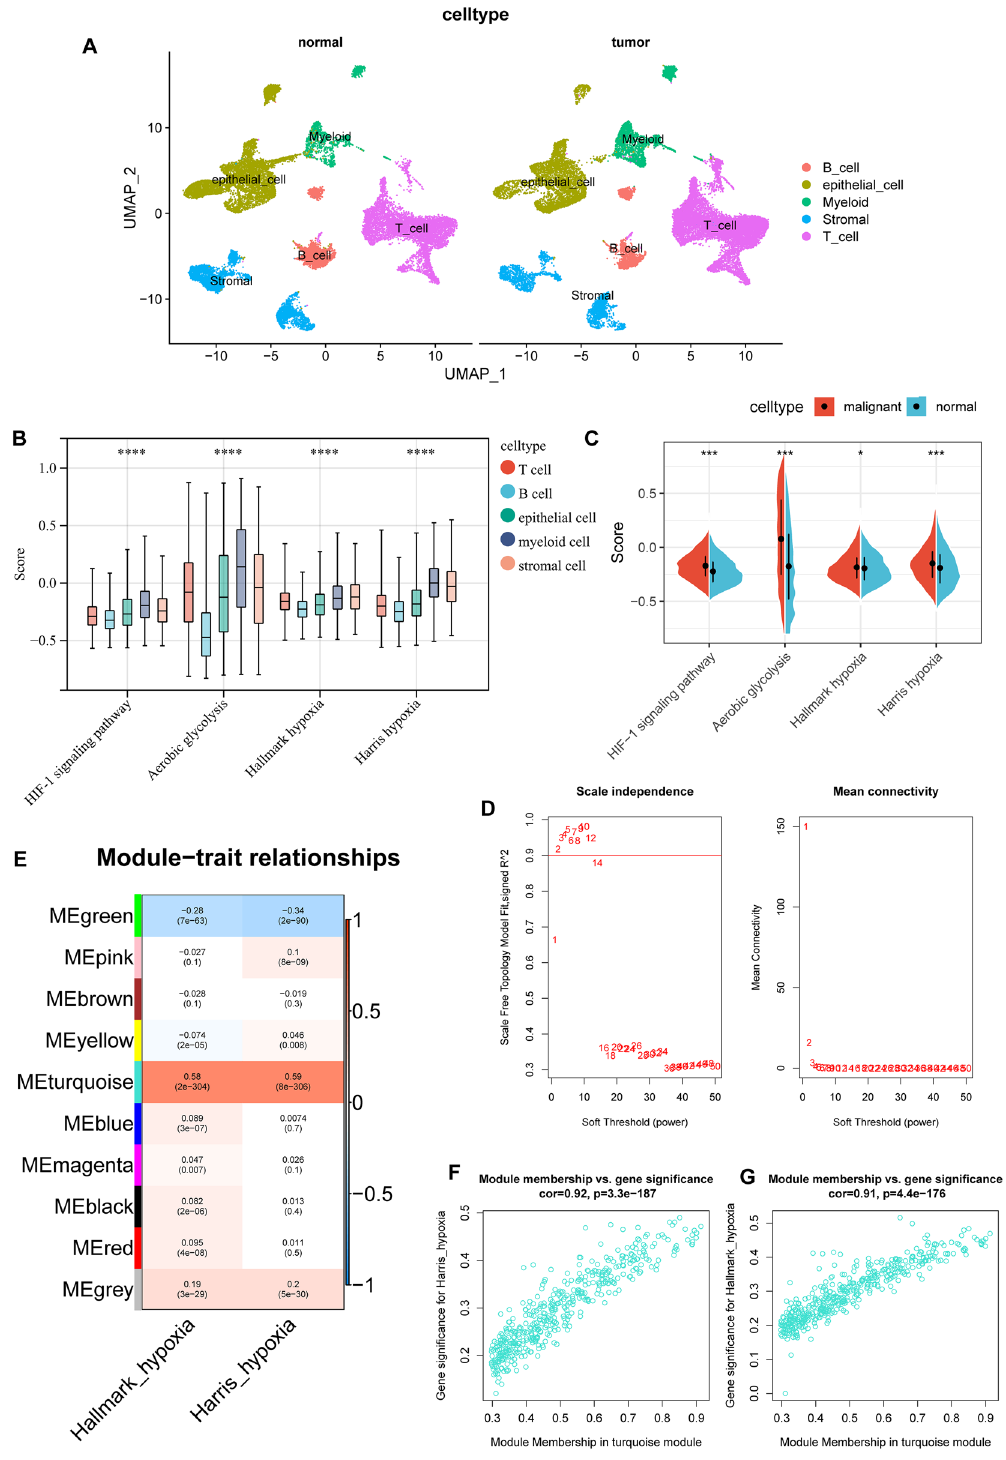
Figure 1. ( A ) The UMAP plot of cells in normal tissue and tumor tissue, which are color-coded based on their associated clusters. ( B ) Differences among the four hypoxia-related pathways among the five types of cells. ( C ) Differences among the four hypoxia-related pathways among malignant and non-malignant epithelial cells. ( D ) Analysis of the scale ‐ free fit index and the mean connectivity for various soft ‐ thresholding powers. ( E ) Table cells showing Pearson’s correlation coefficients and corresponding P-value between module eigengenes (ME) and the variables. ( F,G ) Scatter plots of the gene significance and module membership in turquoise module. The x-axis indicates the module membership (MM) which quantify how close a gene is to a given module. The y-axis indicates the gene significance (GS) which is correlated with clinical